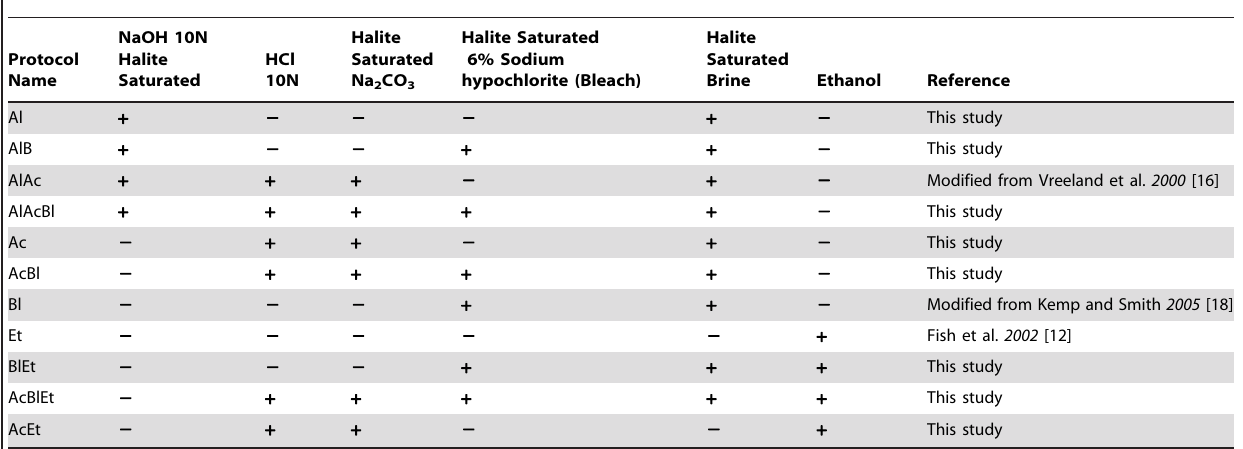
Table 1. List of surface sterilization protocols evaluated and the rinse steps for each.